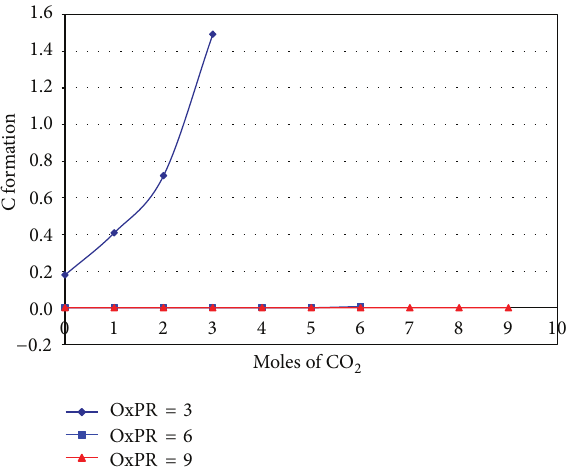
Figure 9: Carbon formation at optimum temperature in CR of Propane.